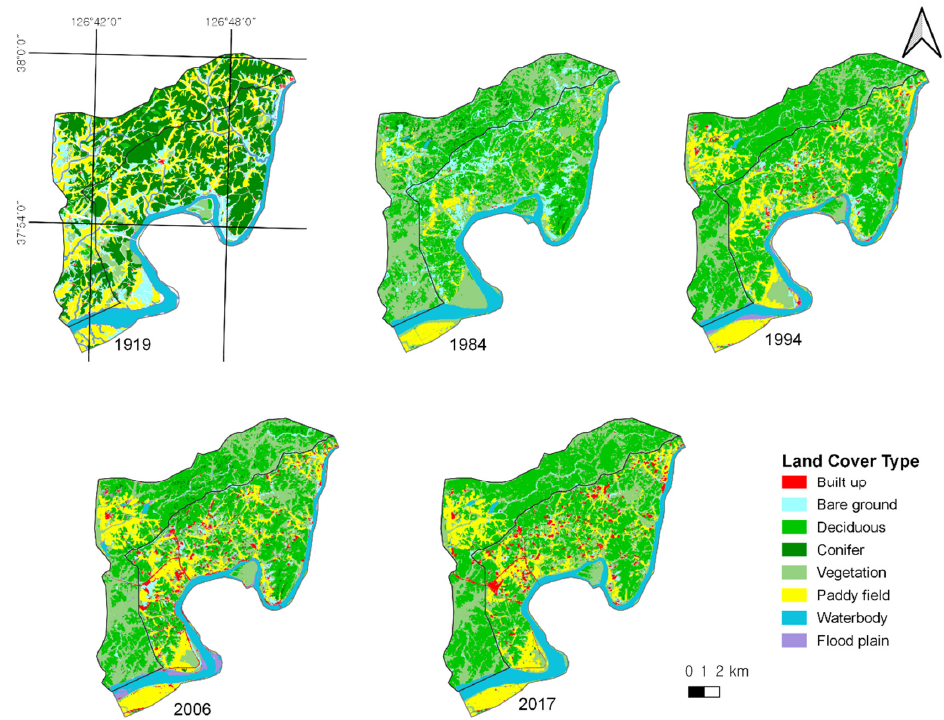
Figure 4. Maps of land-use types in western DMZ and CCZ in Paju-si and Yeoncheon-gun over 100 years (1919–2017) in Korea.